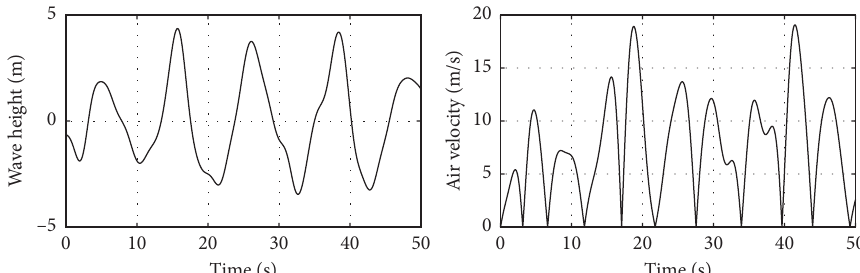
Figure 9: Wave height and corresponding airflow velocity (absolute) for OWC-1 with SW 1.